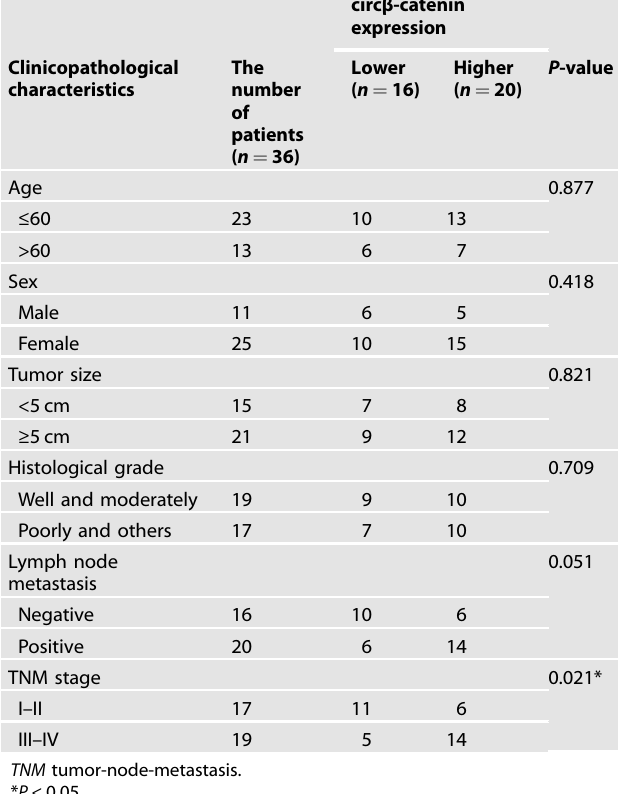
Table 1. The association between circ β -catenin expression level and clinicopathological characteristics in 36 cases of GBC patients.